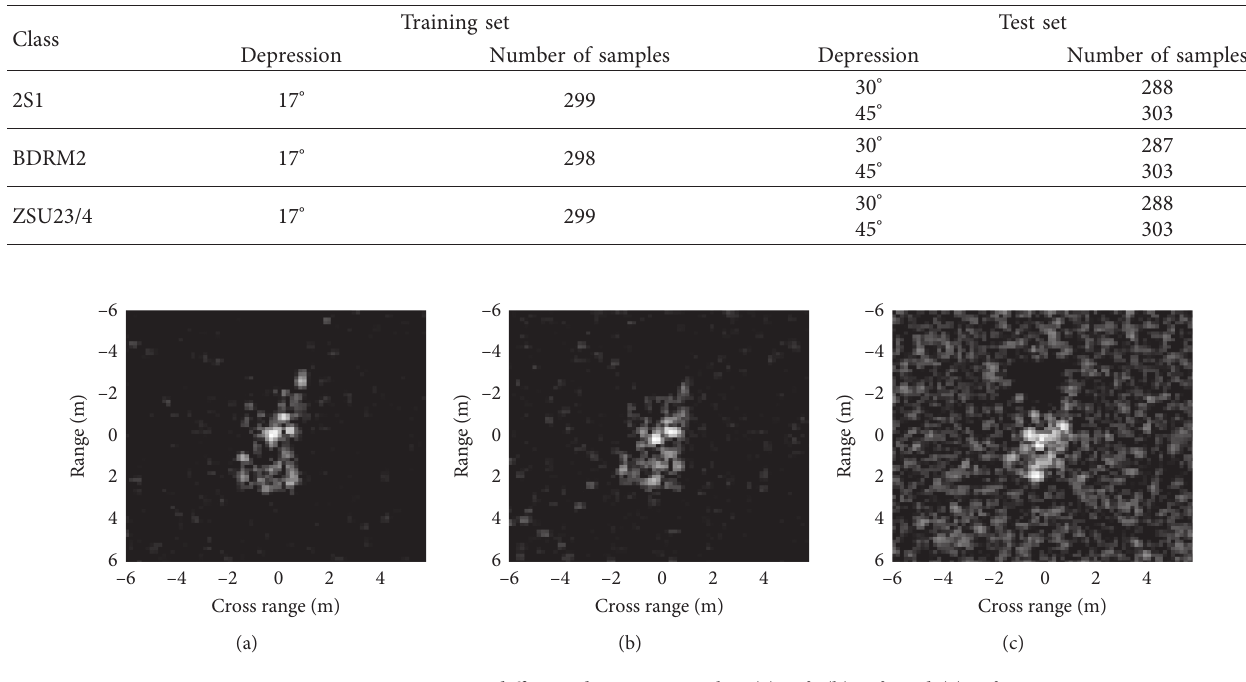
Table 6: Training and test samples under large depression angle variance.